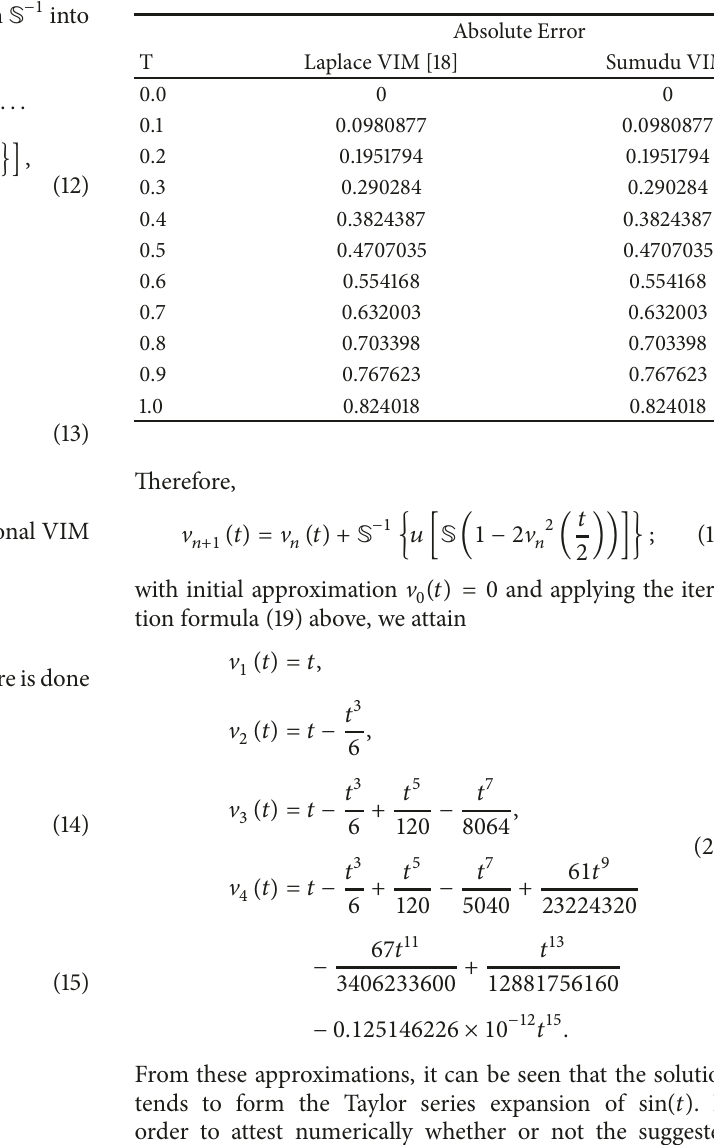
Table 1: Absolute error comparison representing Example